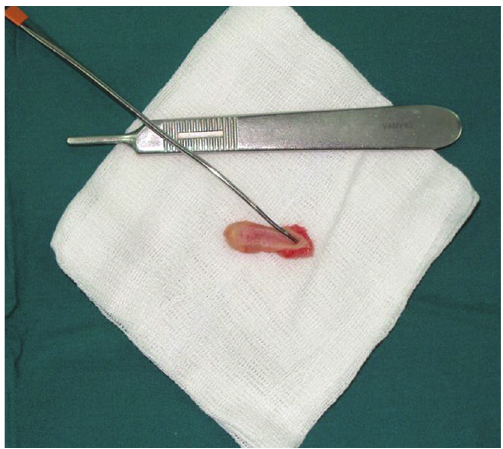
Figure 2: Macroscopic appearance of the excised specimen. The probe is inserted in the caudal blind